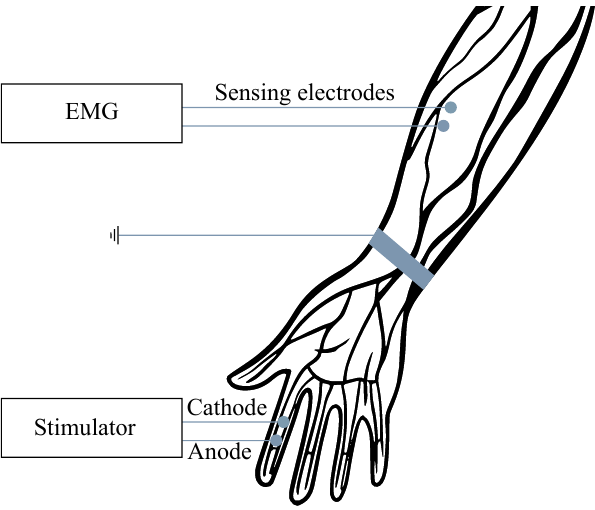
Figure 1. Example of the surface EMG signal